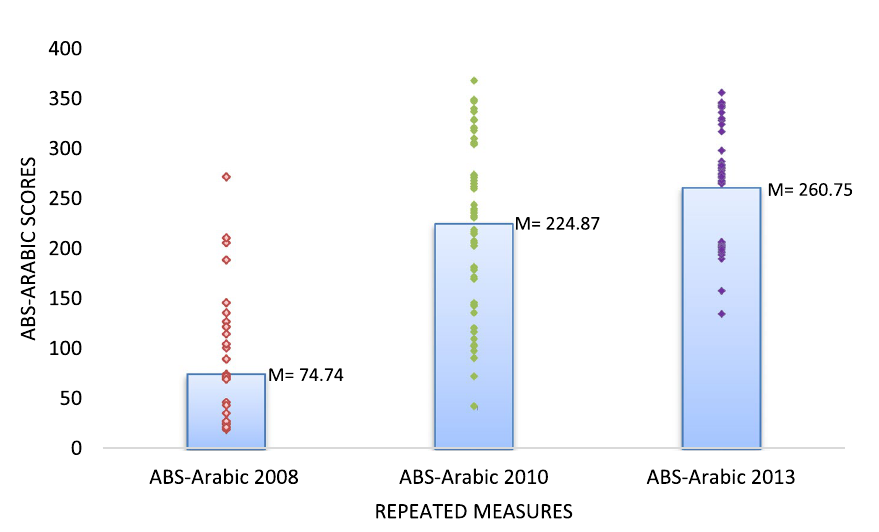
Figure 2. Mean Differences Between Pre-. Post-. and Follow-up Test on ABC (n = 66).